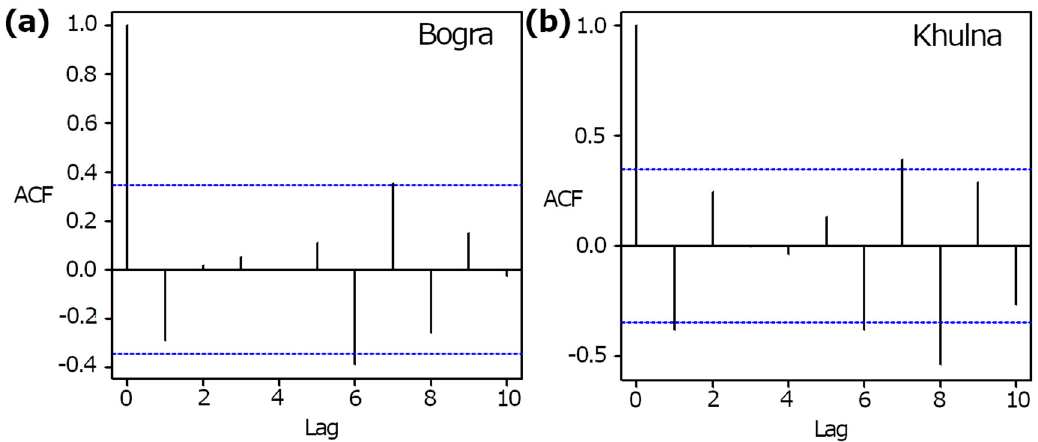
Figure 6. Plots of the autocorrelation function of the annual rainfall of Bangladesh for the period 1979–2010 at: ( a ) Bogra, in the north; and ( b ) Khulna, in the south.